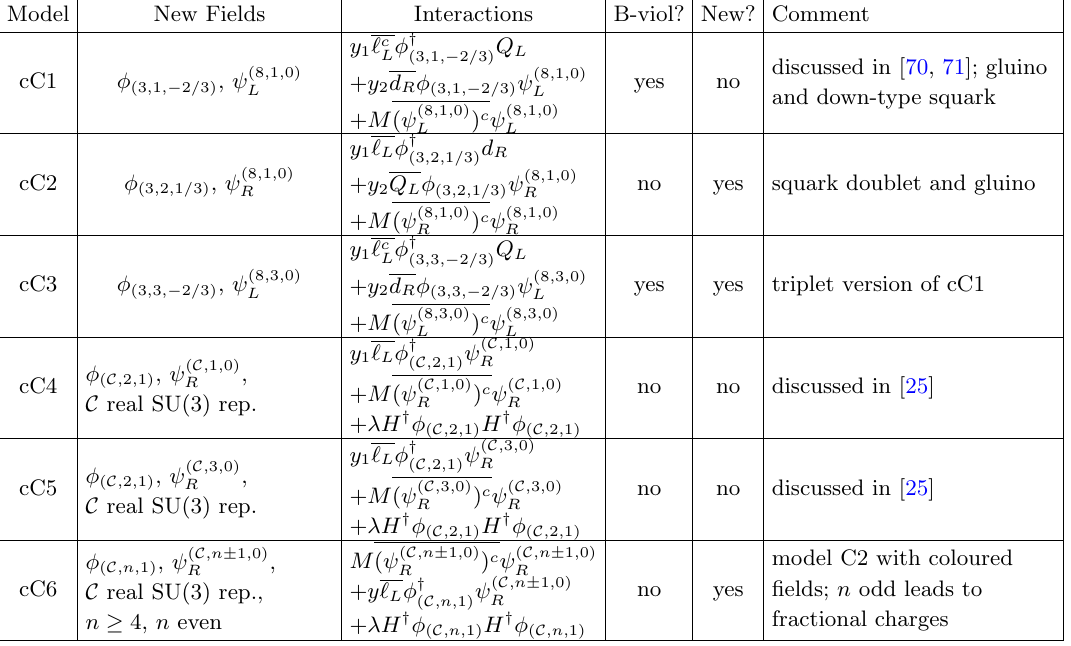
Table 6 . Neutrino mass models with one new scalar and one new Majorana fermion with at least one new coloured